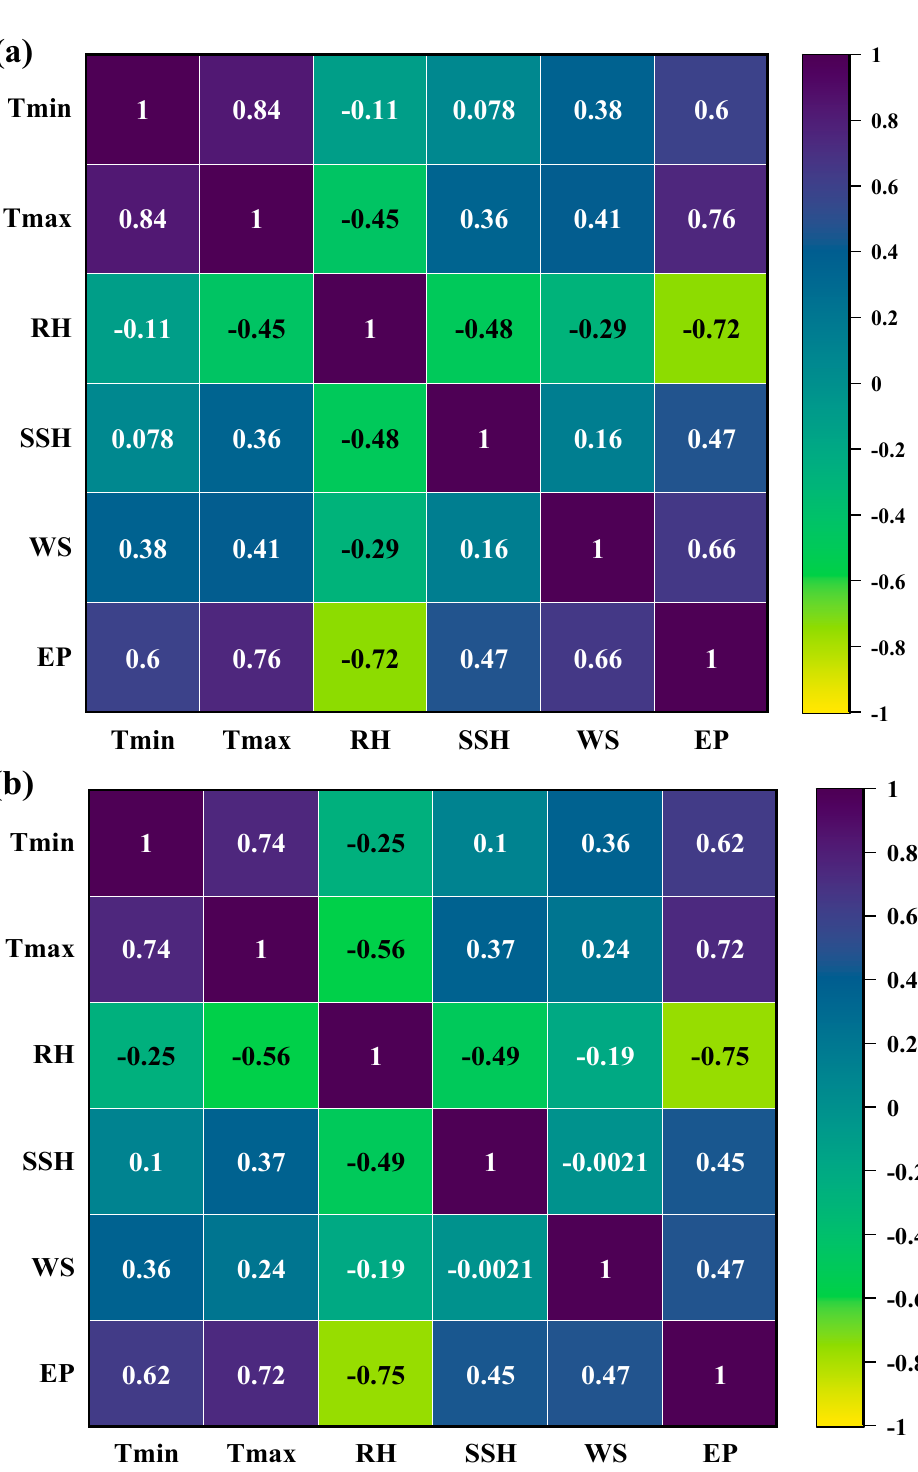
Figure 6. The inter-correlation matrix of selected climatic variables for evaporation at the ( a ) New Delhi and ( b ) Ludhiana stations.